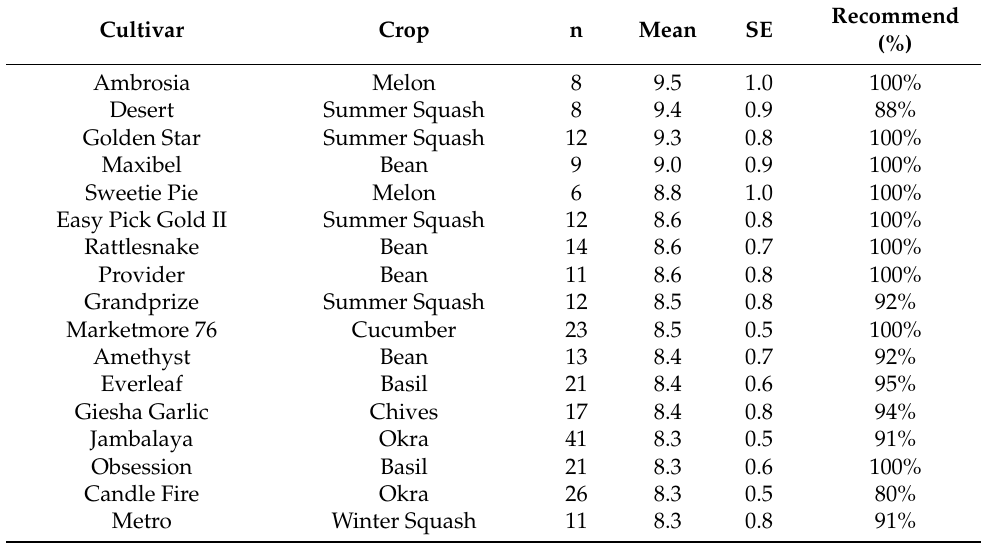
Table 8. Mean performance rating by variety for 2018–2020. Performance was rated on a scale of 1 to 10, with 1 indicating poor performance and 10 indicating excellent performance. The number of participants who returned usable data for each cultivar is reported as